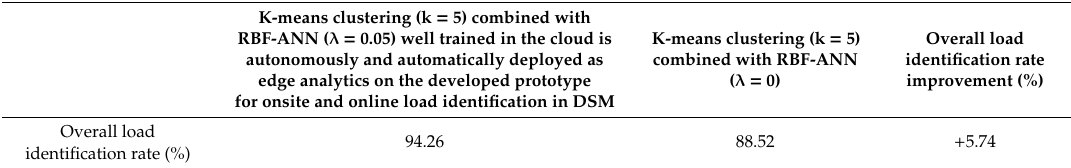
Table 7. Overall load identification rate achieved in this